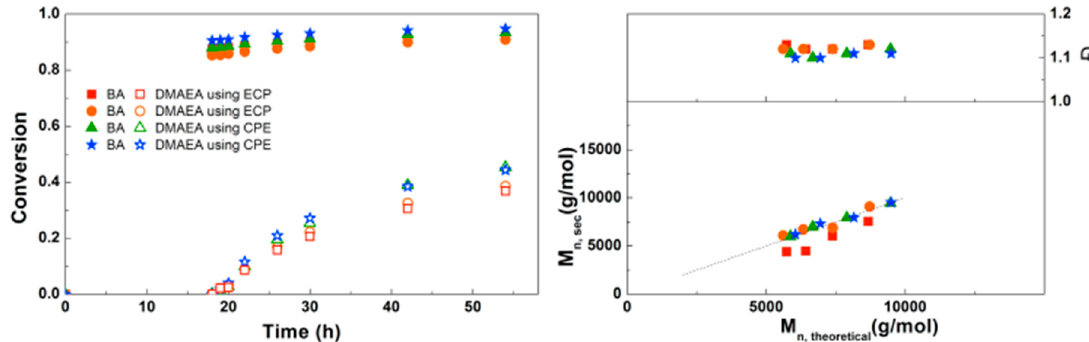
Figure 6. ( Left ): conversion versus time plot for Cu(0)-mediated one-pot block copolymerization of BA and DMAEA using [BA]:[DMAEA]:[ECP]:[Me 6 TREN]:[CuCl 2 ] = 50:50:1:0.15:0.1 and [BA]:[DMAEA]:[CPE]:[Me 6 TREN]:[CuCl 2 ] = 50:50:1:0.3:0.2, 3.0 M in DMF at 25 °C and 12.5 mm 2 /mL Cu(0) wire. A 3.0 M solution of DMAEA in DMF was added after 18 h reaction time. ( Right ): corresponding molecular weight and dispersity versus theoretical molecular weight plot.